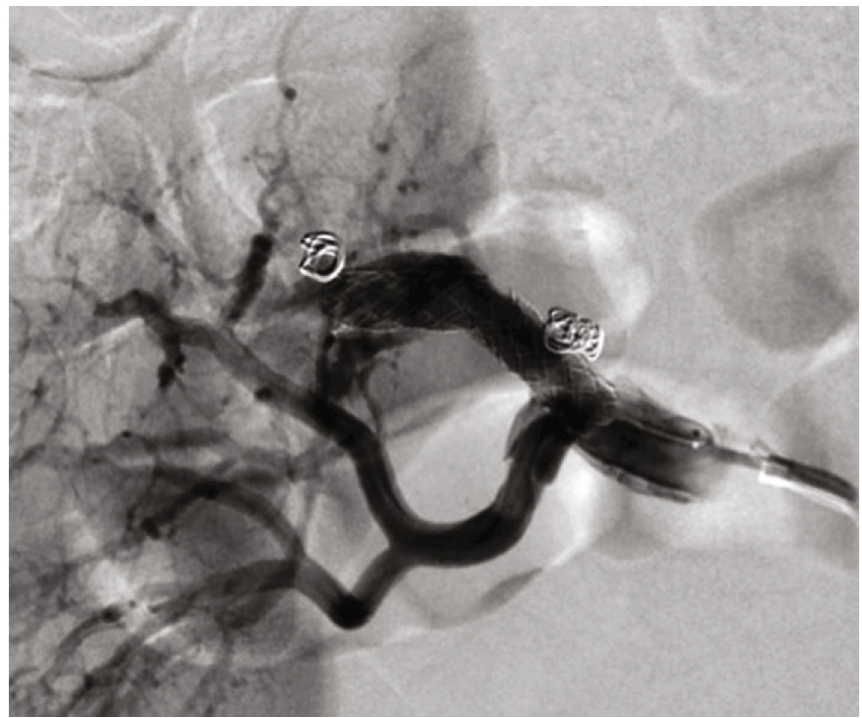
Figure 4: The false lumens are occluded by coiling, and the narrowing is